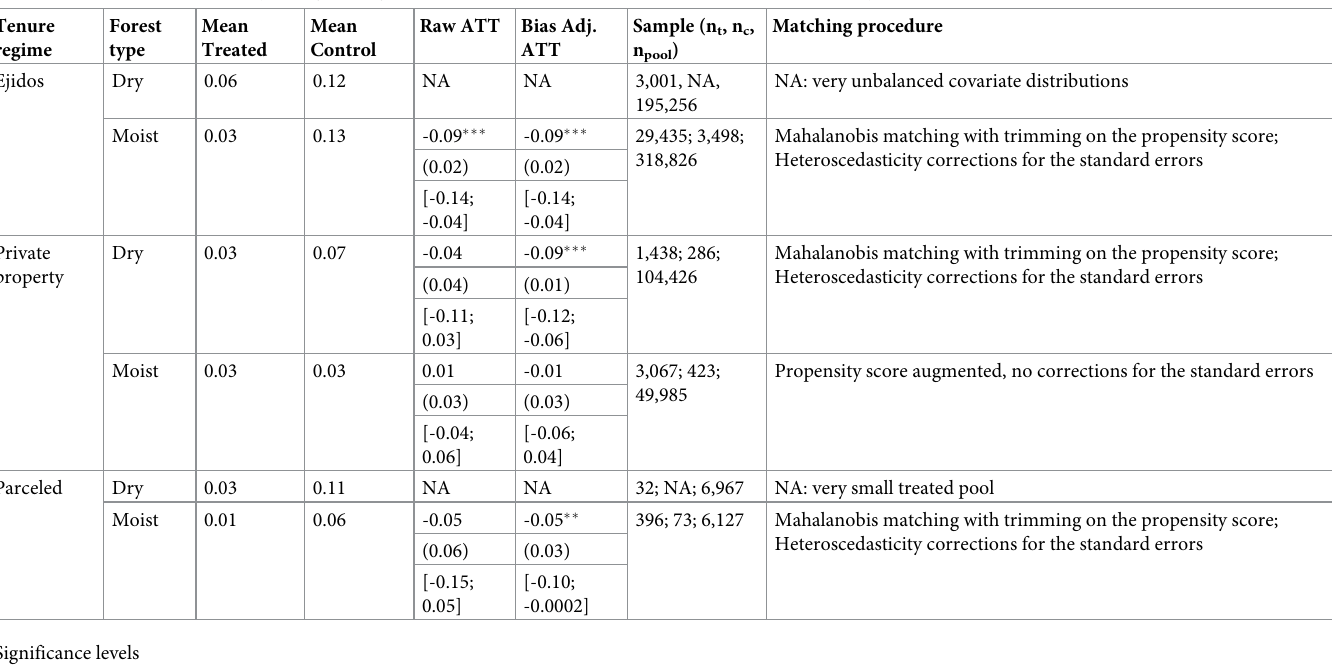
Table 4. Average direct impacts of protection by tenure regime, proxied by the average treatment effect on the treated (ATT). The observations falling within pro- tected areas (treatment) are compared to observationally similar unprotected pixels (control) in properties not intersecting a protected area. The standard errors are given in parentheses and confidence intervals corresponding to each significance level—in square brackets. n t , n mc , n cp indicate treated (on support), matched control, and con- trol pool observations, respectively. A negative sign of the ATT indicates that protection reduced the probability of forest